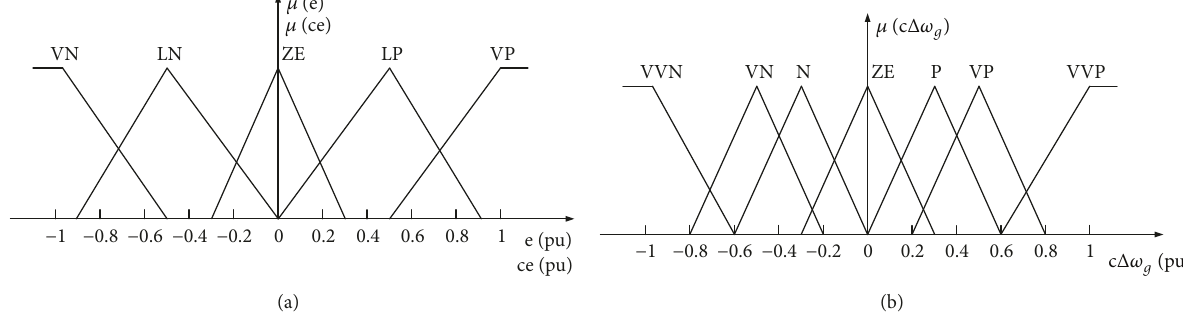
Figure 5: Membership functions of the developed Mamdani-type FC.